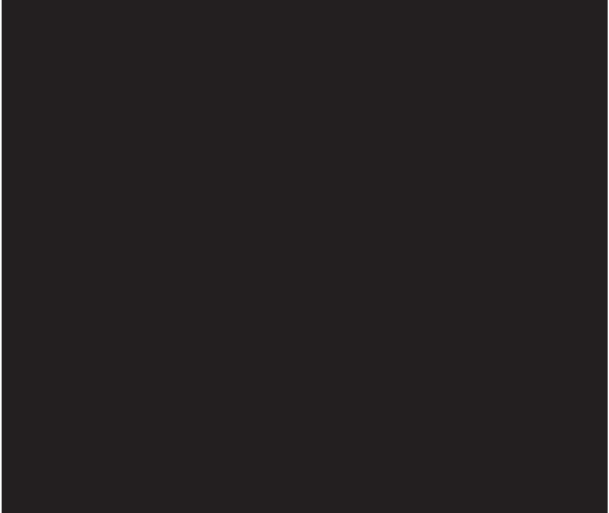
Figure 3. Illustration of the Garwood, et al. model of a deep rectangular tank with propeller agitators in each of the four